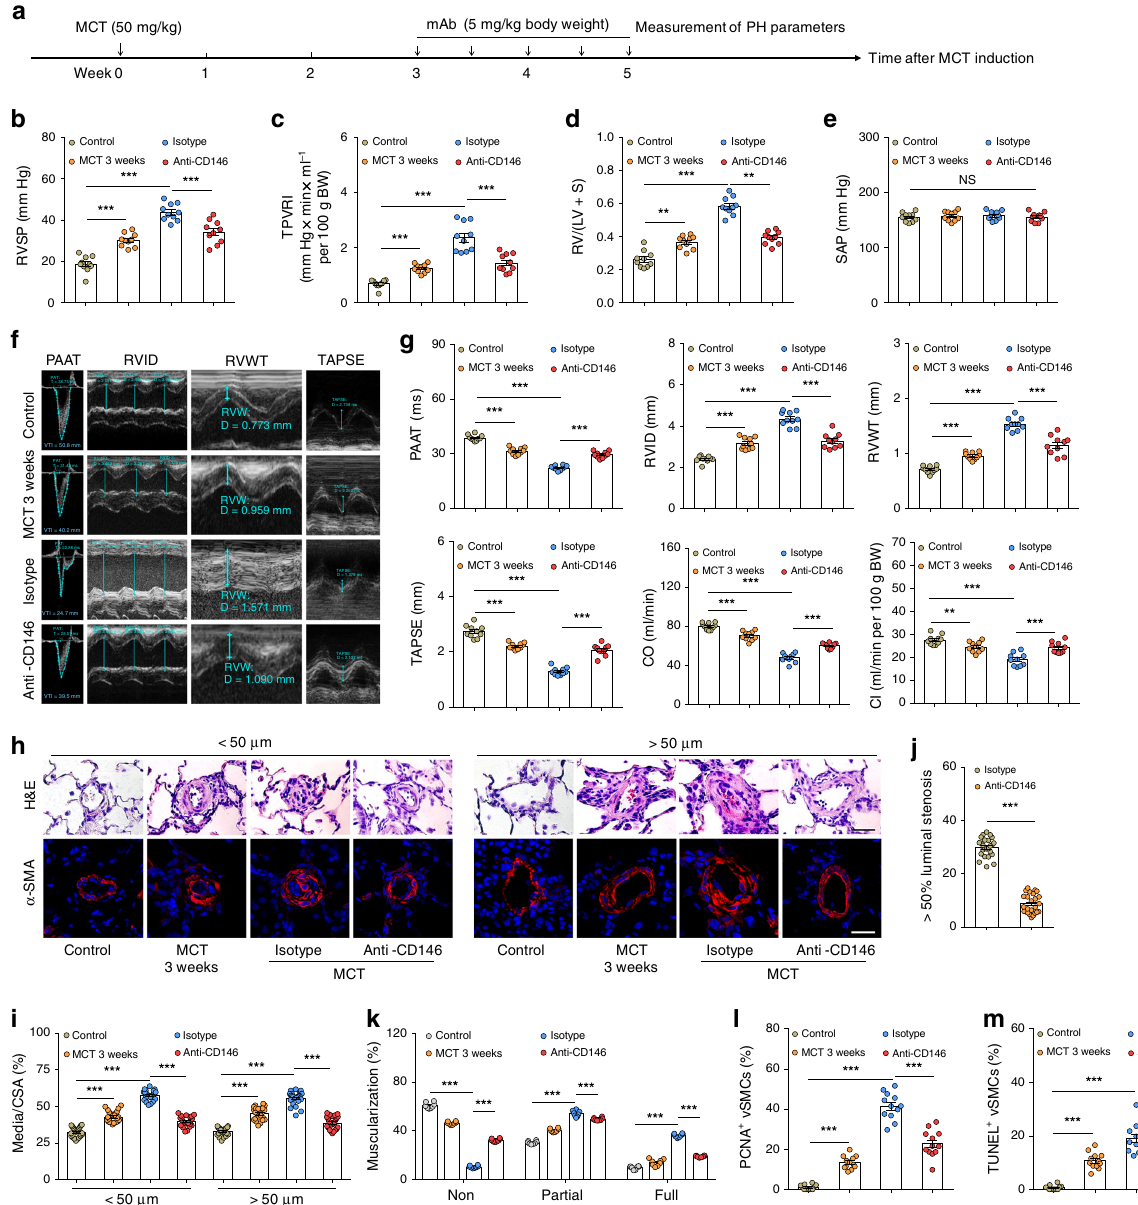
Fig. 7 Targeting CD146-HIF-1 α axis attenuates MCT-induced PH in rats. a Schematic of CD146-targeted therapy in MCT-induced PH in rats. b – e RVSP b , TPVRI c , SAP d and RV/(LV + S) e in anti-CD146- or mIgG-treated rats after 5 weeks of MCT ( n = 10 rats per group). f Echocardiographic (PAAT, RVID, RVWT, and TAPSE) measurements and images. g Echocardiography measurements were carried out on anti-CD146- or mIgG-treated rats after 5 weeks of MCT to determine PAAT, RVID, RVWT, TAPSE, CO, and CI ( n = 10 rats per group). h Representative images of H&E and immuno fl uorescent staining of PAs (20 – 50 μ m or 51 – 100 μ m in diameter) stained with α SMA (green). Scale bar, 50 μ m. i Quanti fi cation of vascular medial thickness for images in h ( n = 5 rats per group, fi ve PAs per rat). j Quanti fi cation of PAs with >50% luminal stenosis ( n = 5 rats per group, fi ve PAs per rat). k Proportion of non-, partially-, or fully- muscularized pulmonary arterioles (20 – 50 μ m in diameter) from MCT-treated rats ( n = 8 rats per group). l Quanti fi cation of the relative number of PCNA + / α SMA + cells ( n = 4 rats per group, three PAs per rat). m Quanti fi cation of the number of TUNEL + cells ( n = 4 rats per group, three PAs per rat). In all statistical plots, the results are expressed as mean ± s.e.m. * P < 0.05, ** P < 0.01, *** P < 0.001. n.s., not signi fi cant; one-way ANOVA